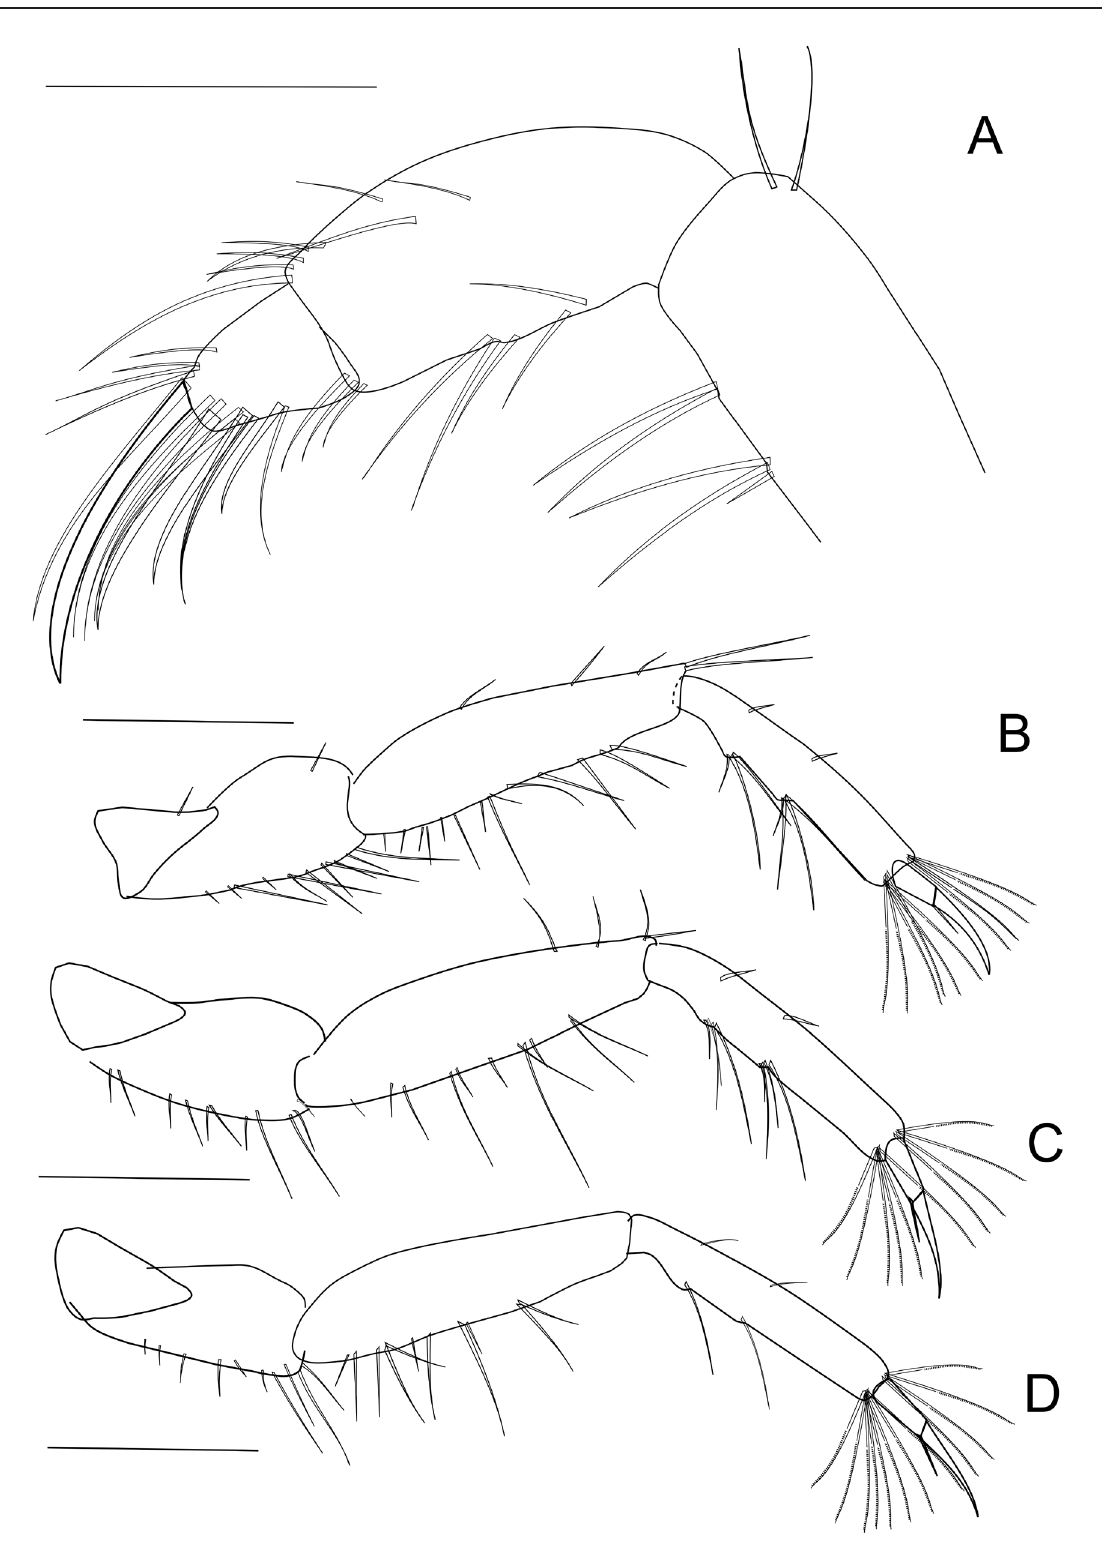
Fig. 16. Siriella muranoi sp. nov., holotype, ♂, length 5.5 mm, Port Essington, Arafura Sea, Northern Territory, Australia. A . Anterior part of maxilliped 2, posterior view. B . Endopod of pereopod 1, posterior view. C . Endopod of pereopod 2, posterior view. D . Endopod of pereopod 3, posterior view. Scale bars: A = 0.2 mm; B–D = 0.25